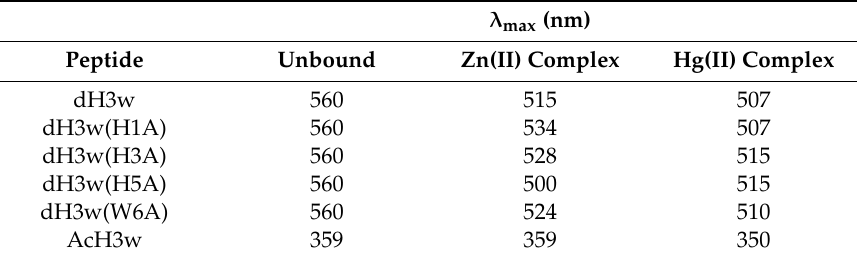
Table 1. λ max values of dH3w and its variants.